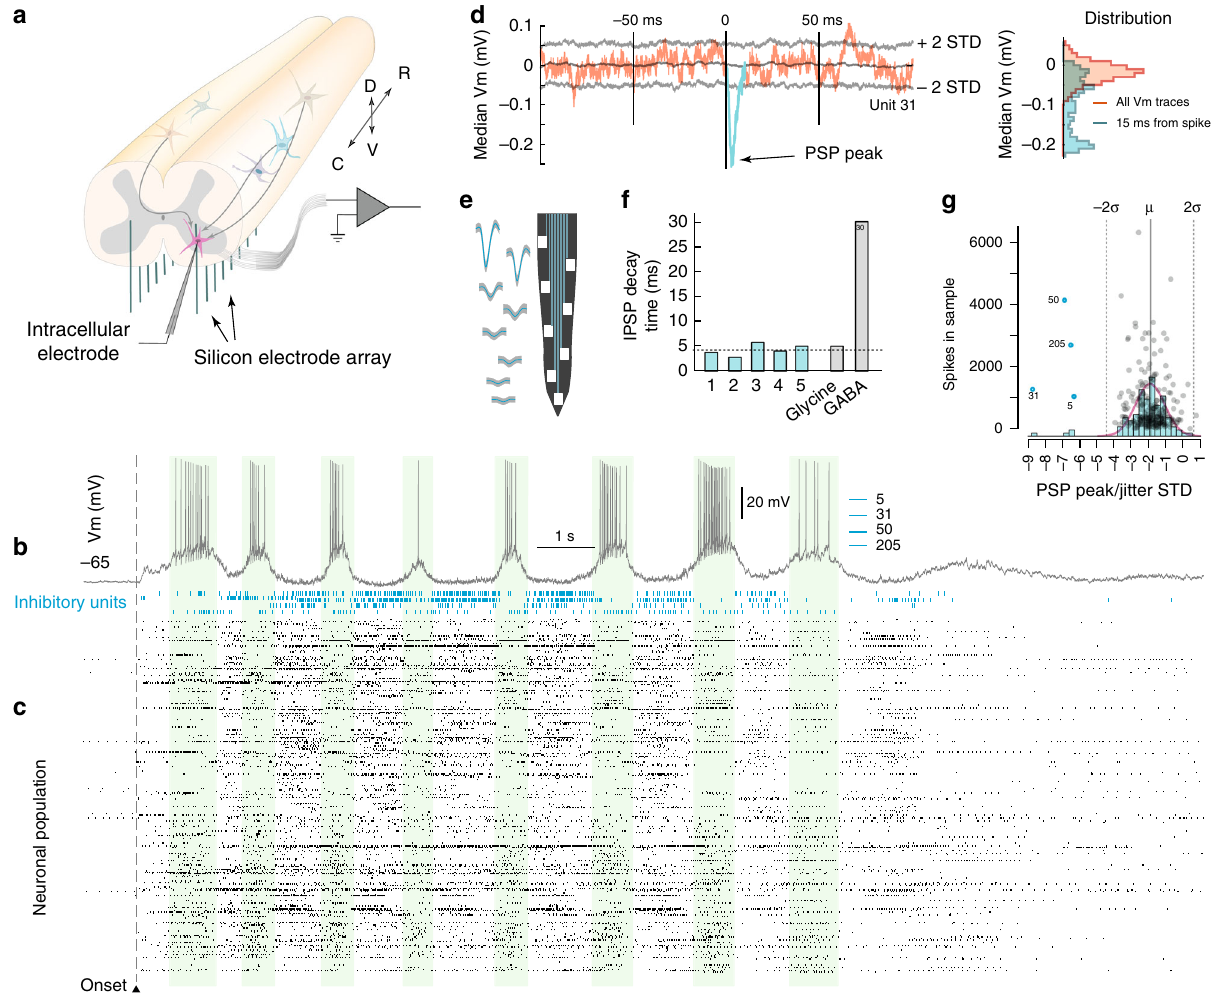
Fig. 8 The lumbar connection probability is small. a Local inhibitory and excitatory connections are veri fi ed by combining intra – cellular recording ( V m ) with extracellular multi – electrode arrays (inserted ventrally). b V m during motor activity with the nearby neuronal population ( c , n = 249). Four inhibitory cells were identi fi ed (blue rasters). d Spike – triggered median V m indicates an inhibitory post-synaptic potential (IPSP) with a signi fi cant peak (cf. red and blue traces). Gray lines indicate ±2 standard deviations of a jittered distribution. e Waveforms of an inhibitory cell d on shank electrodes. f IPSP decay time constants for the signi fi cant 5 units (green) indicate glycinergic rather than GABAergic inhibition (gray). g PSP peaks normalized by the jitter distribution standard deviation scatter plotted against the number of spikes in the sample. Only 4 units (blue) were signi fi cant in this data